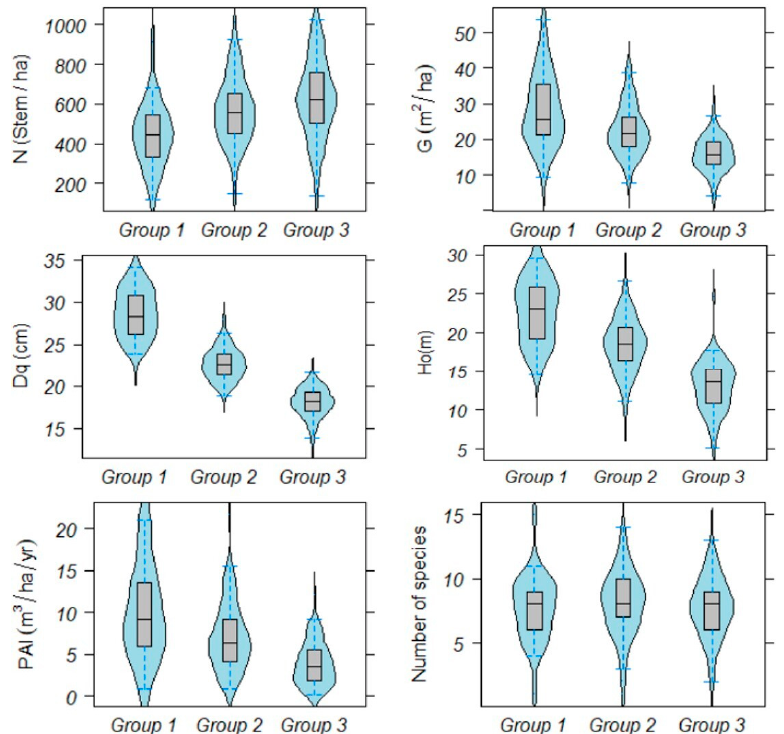
Figure 3. Forest conditions by class of density. Width represents relative density within each bin and the boxplot represents the quartiles. All the variables showed significant differences ( p ≤ 0.05) according to Dunn’s test, except for the number of species, which was not significantly different among groups. N, G, Dq, Ho, and PAI are defined in Table 1.